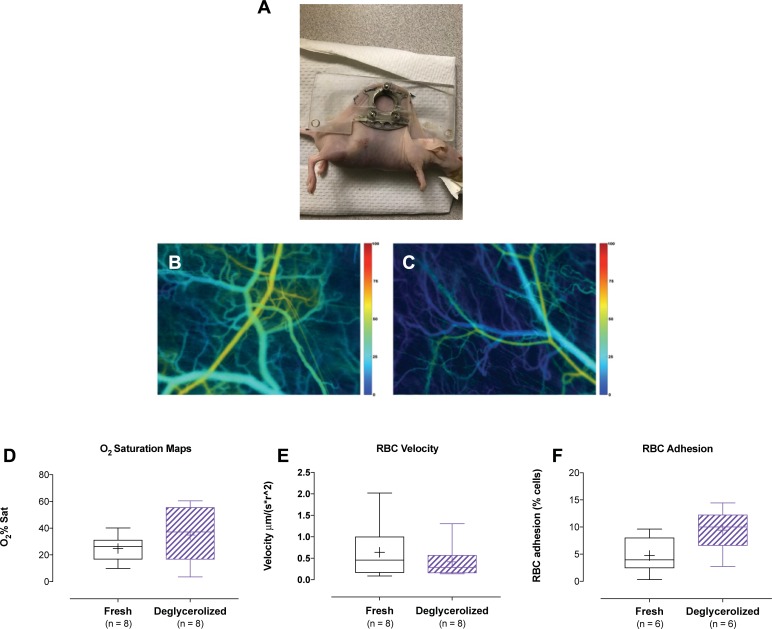
Dorsal window chamber set up for the assessment of in vivo hemoglobin O2 saturation, RBC velocity and vascular adherence of transfused fresh or matched deglycerolized RBCs.(A) Image of the dorsal window chamber set up. (B and C) No difference was observed in mapped hemoglobin O2 saturation, or (D) RBC velocity in the dorsal skinfold window chamber model, between the transfusion of fresh or deglycerolized RBCs. (E) A modest, but statistically insignificant difference was observed on in vivo adhesivity of transfused RBCs between fresh and deglycerolized RBCs from the same donors.